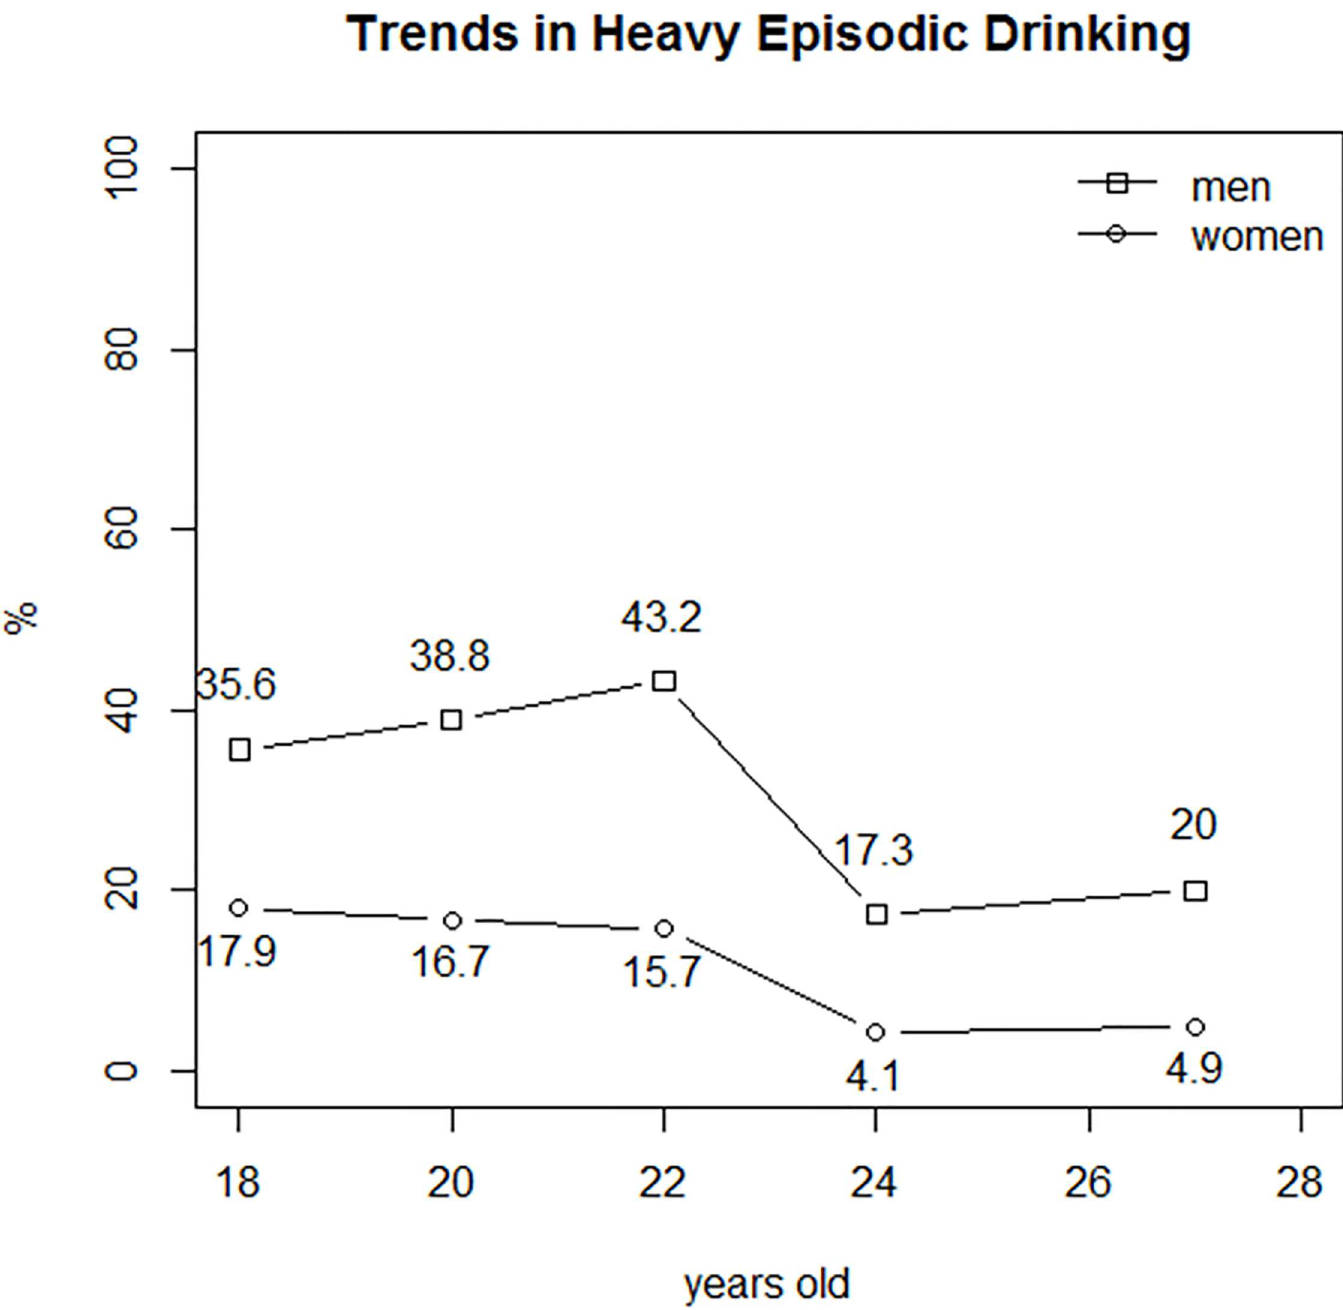
Fig 2. Prevalences of heavy episodic drinking among female and male spanish university students from 18–19 years old to 27–28 years old.